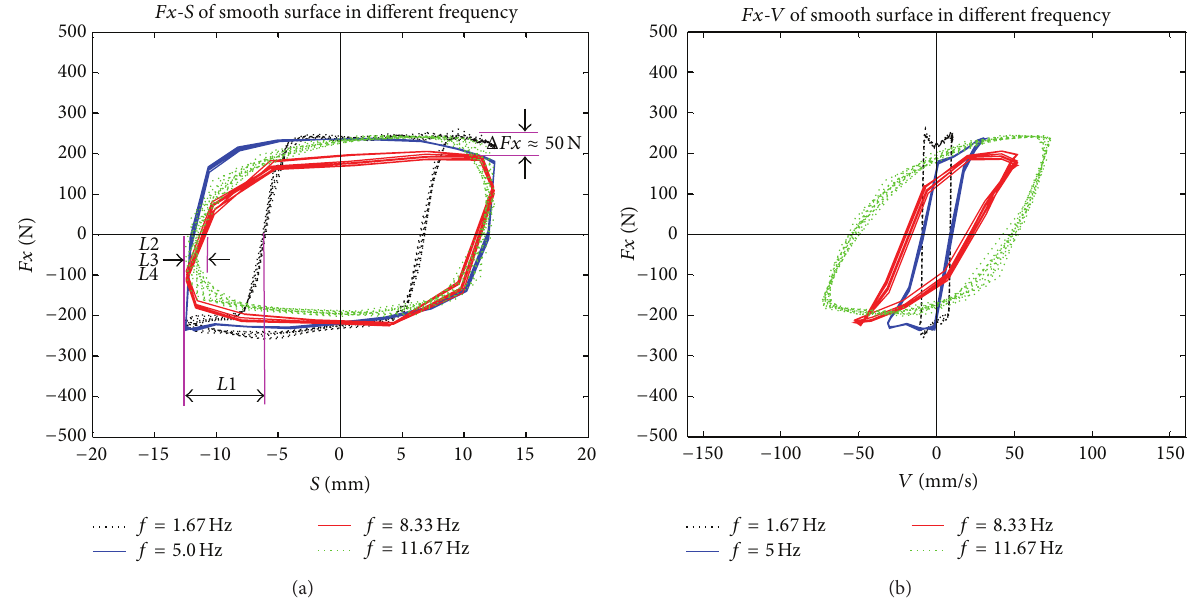
Figure 10: The patterns of (a) relative displacement and (b) relative velocity during the stable friction process of smooth surface at four different reciprocating frequencies.